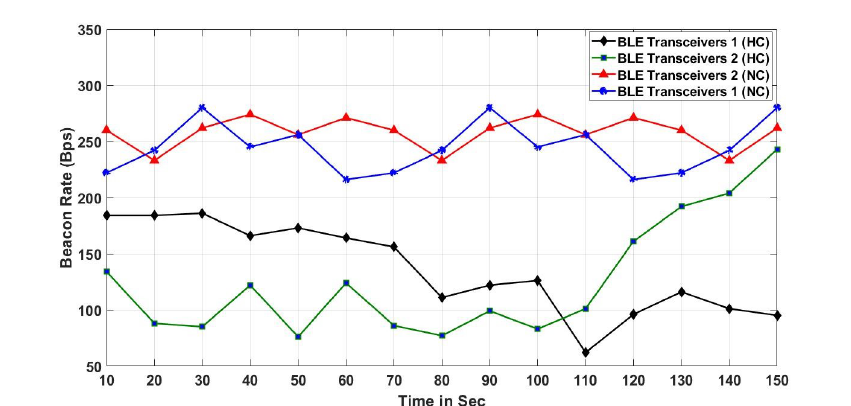
Figure 17. Beacon counts for BLE